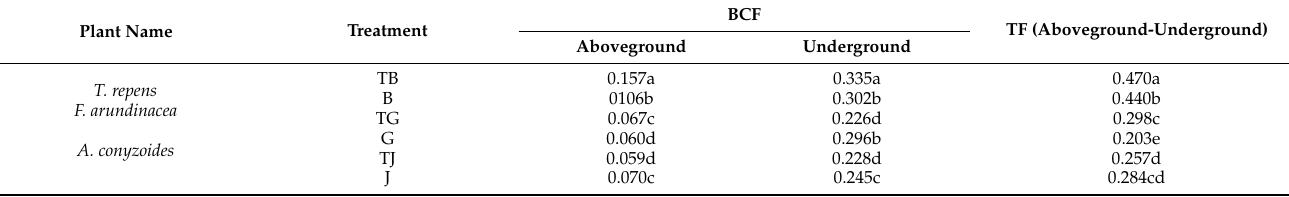
Table 6. TF and BCF of Cr-tolerant garden plants under different